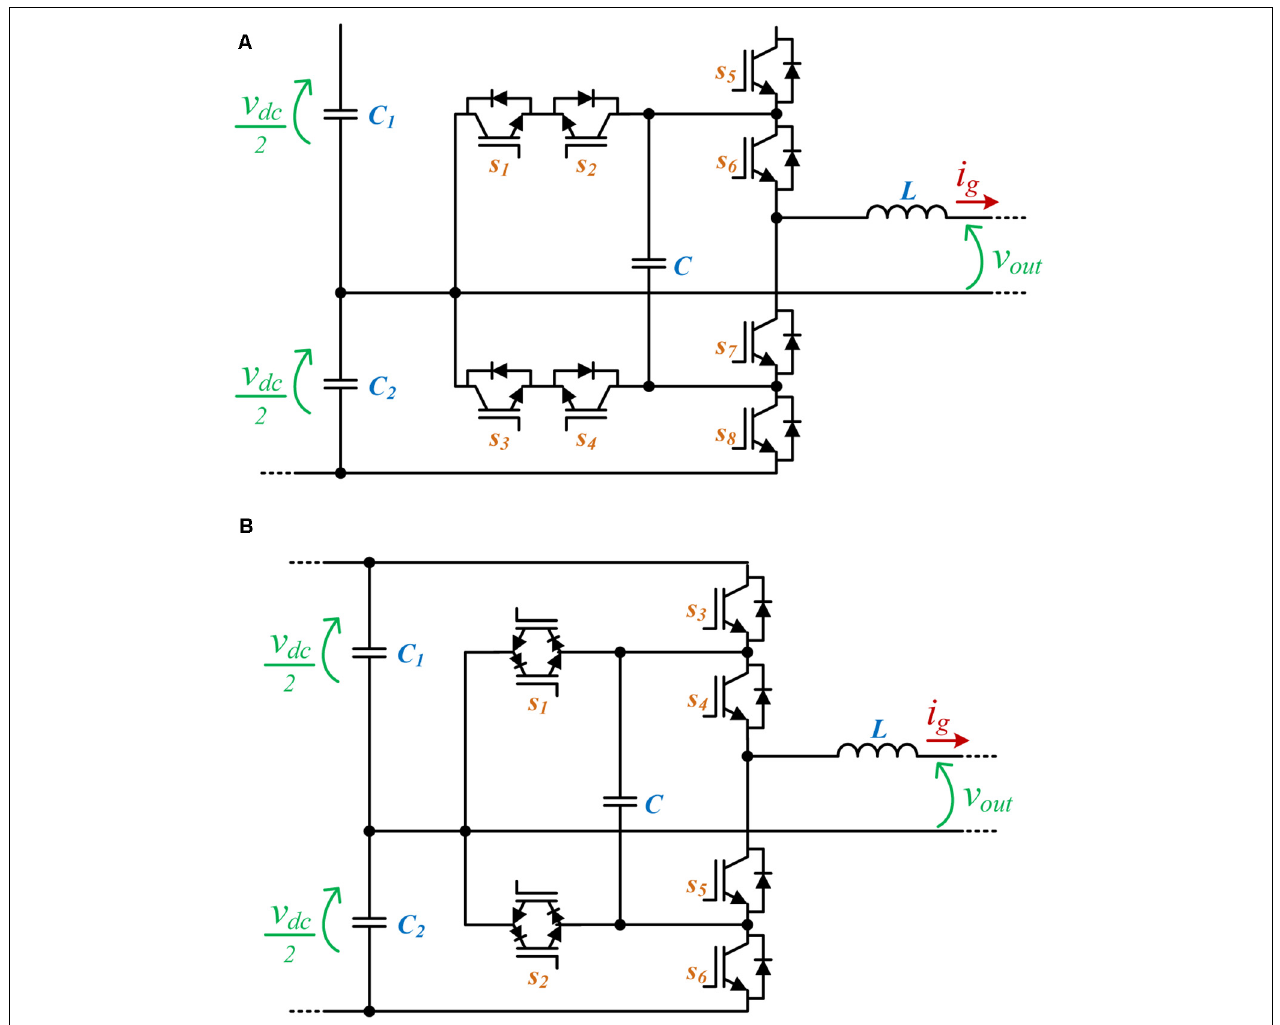
FIGURE 2 | Topologies: (A) proposed in Korhonen et al. (2014); (B) proposed in Yuan